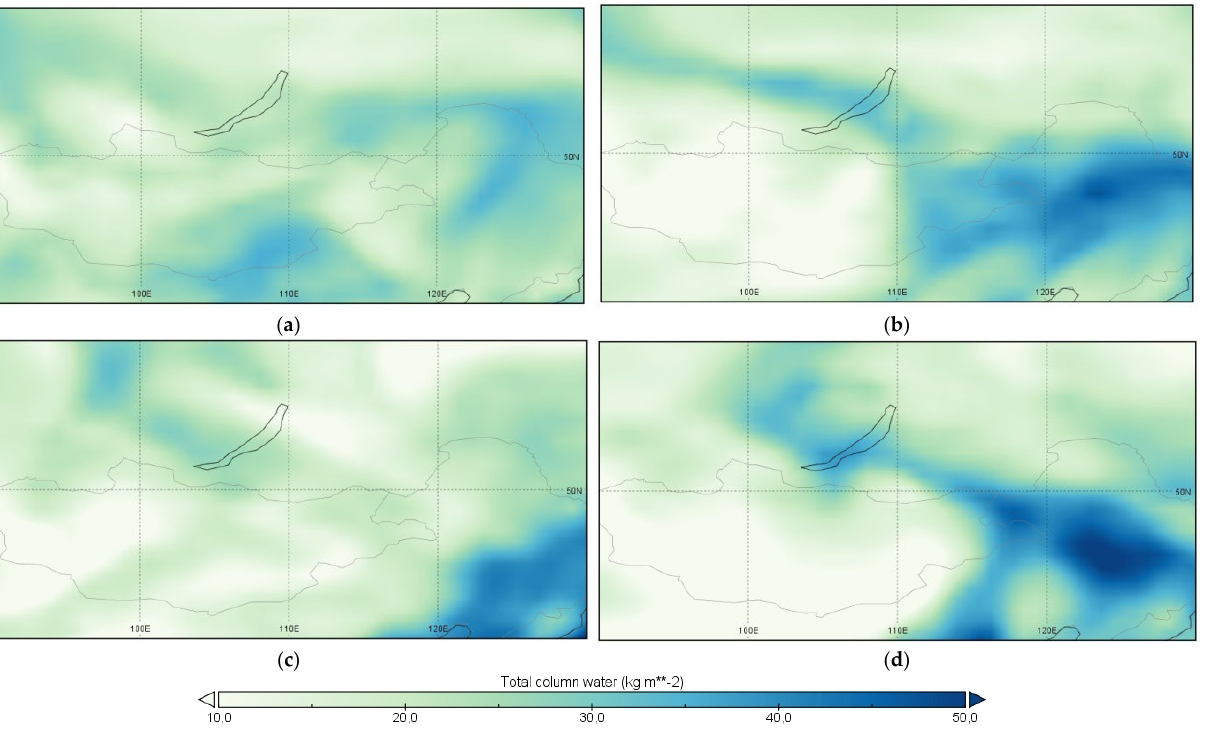
Figure 8. Total column water for maximal EASM jump during cyclonic wave breaking 23–25 June ( a , b ) and 26–27 ( c , d ) July 2019. Era-Interim data.